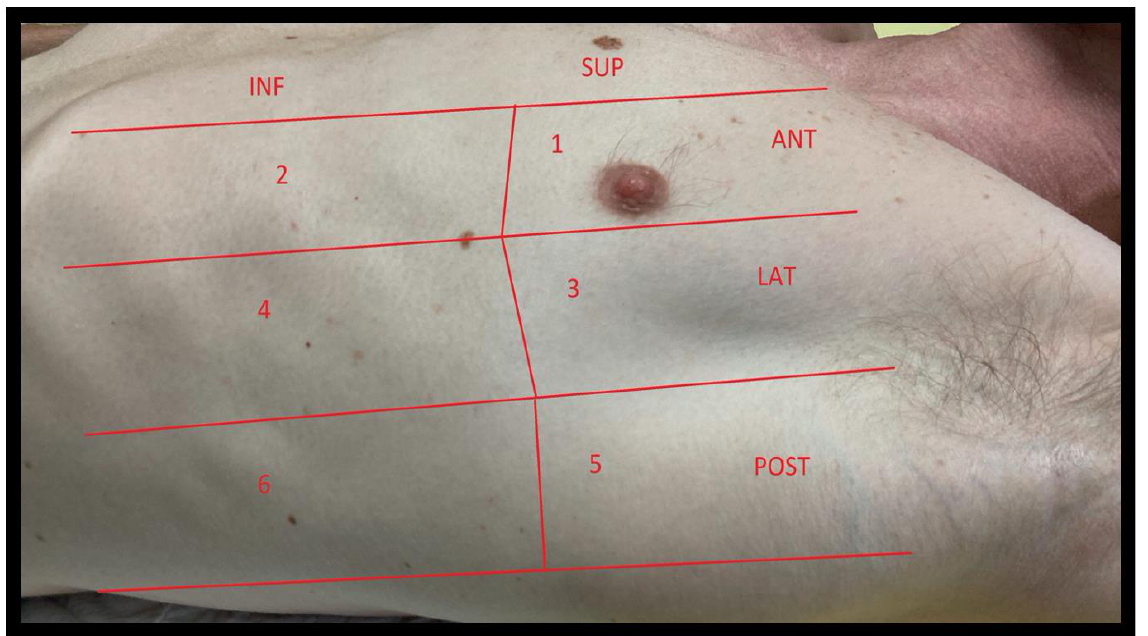
Figure 5. Six areas per hemithorax approach for LUS examination in ICU. Each hemithorax is divided into three areas, using anterior and posterior axillary lines (anterior, lateral and posterior). Each area is divided into two areas: superior and inferior. The LUS score is calculated on a total score of 36 (each area is evaluated as 0 to 3). ANT: Anterior; LAT: Lateral; POST: Posterior; SUP: Superior; INF: Inferior.